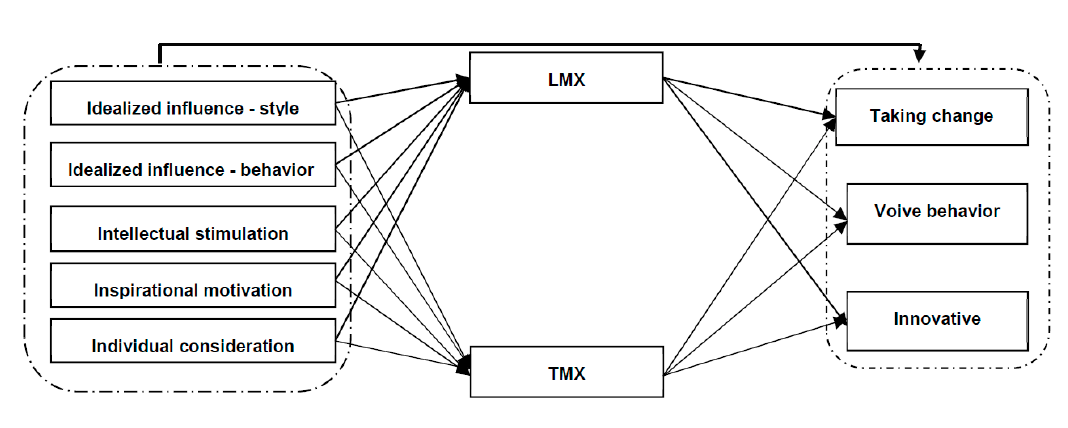
Figure 1. Research model.